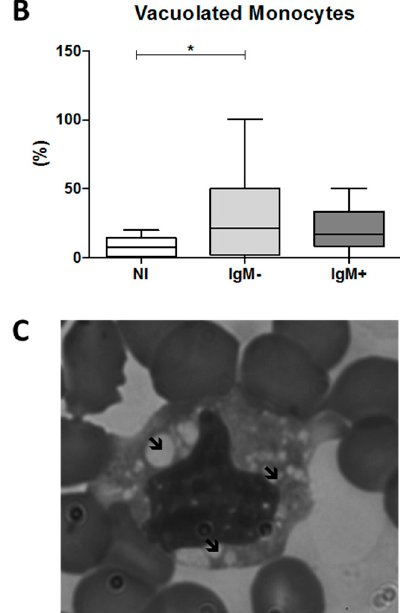
Figure 4. Quantification of DENV viral load and percentage of vacuolated monocytes in the blood collected from dengue patients. Data represent the median, quartiles and extreme values. ( A ) The quantification of viral load was performed by RT-qPCR. DENV RNA copies per mL of plasma. IgM − , DENV-infected individuals showing the absence of IgM in plasma ( n = 12); IgM + , DENV-infected individuals showing the presence of IgM in plasma ( n = 16). The analysis was determined by the Mann–Whitney t -test; ( B ) percentage of vacuolated monocytes was determined using blood smears. NI ( n = 12), IgM − ( n = 12), IgM + ( n = 11). (*) p < 0.05 and (**) p < 0.01. The analysis was determined by ANOVA/Student Newman–Keuls test; ( C ) representative image of a vacuolated monocyte in the blood from a dengue patient, 1000× magnification. = indicate the vacuoles.